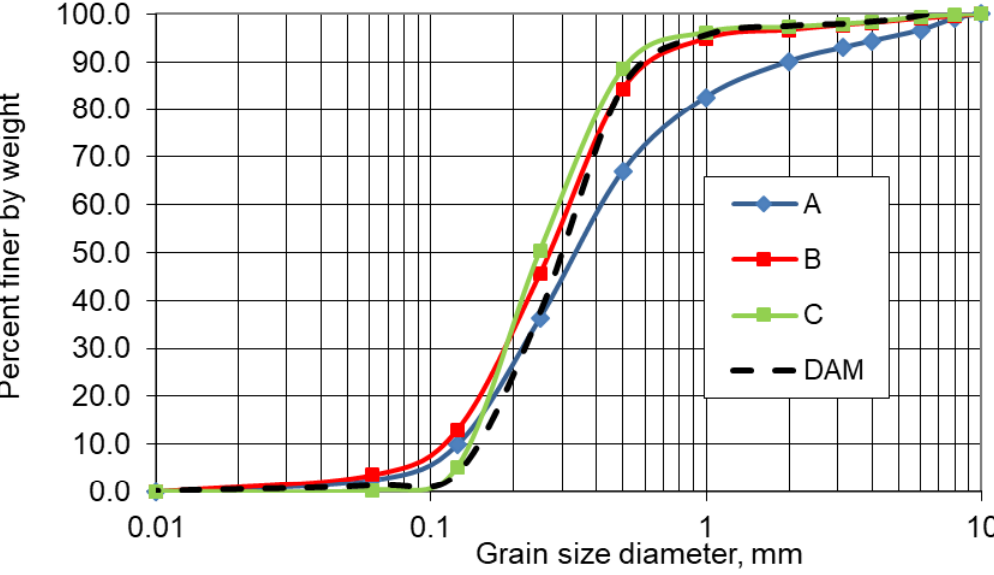
Figure 13. Grain size distribution curve of soil from the 10 cm layer directly at nonwoven geotextile and earth dam material.